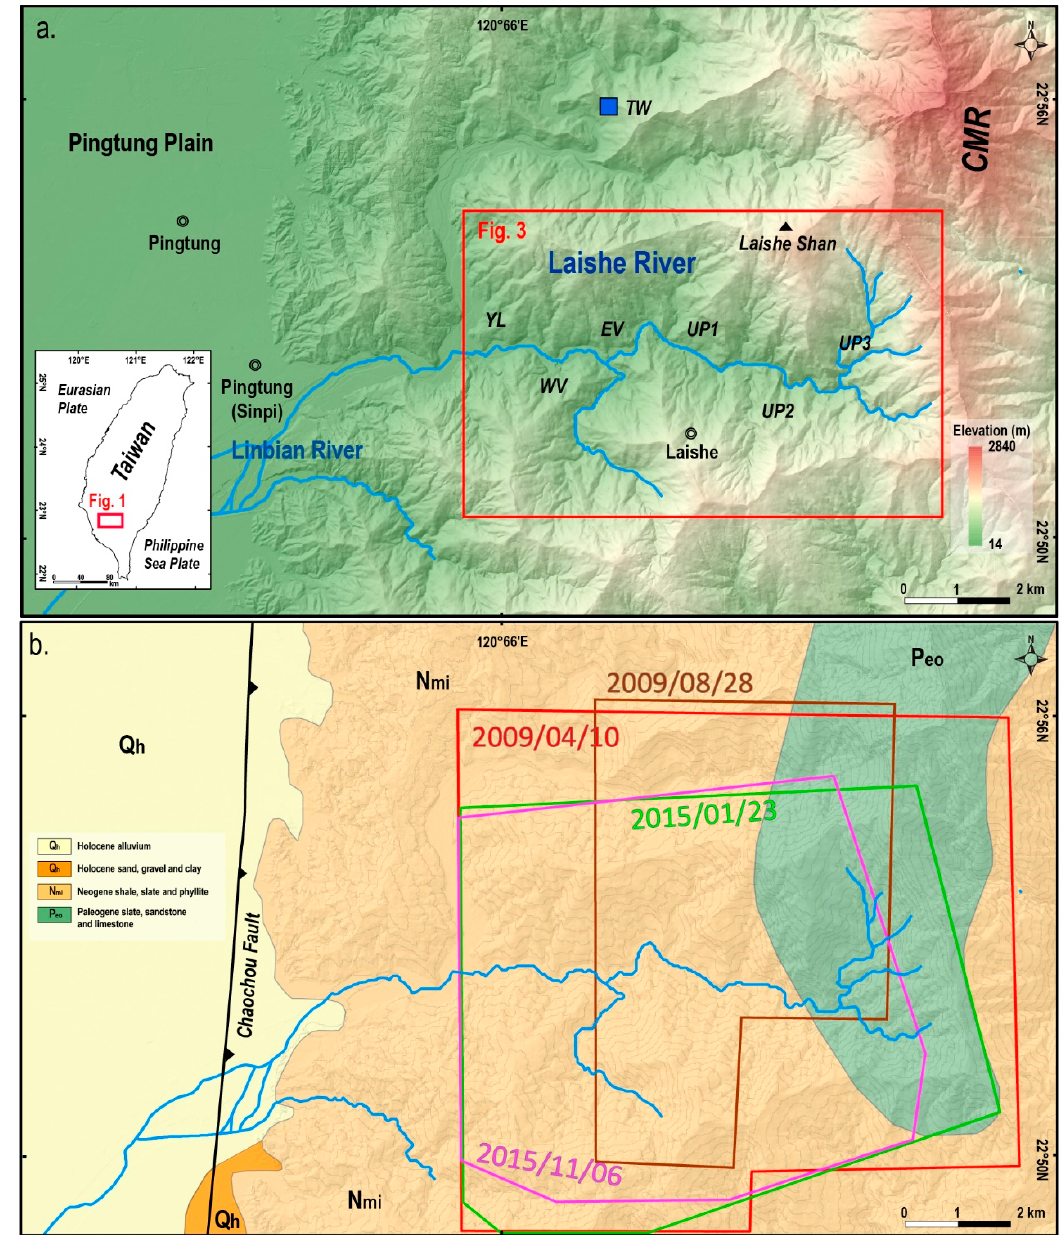
Figure 1. Location and geological background of the study site. ( a ) Color-shaded relief map showing the geographic location of the study site. UP3: upstream 3; UP2: upstream 2; UP1: upstream 1; EV: east village; WV: west village; YL: Yilin; TW: Taiwu: TW, a meteorological station. ( b ) Geological map of the sample site in this study; the square areas denote the Unmanned Aerial Vehicles (UAV) survey area in this study and the colors denote the various missions in the UAV survey.